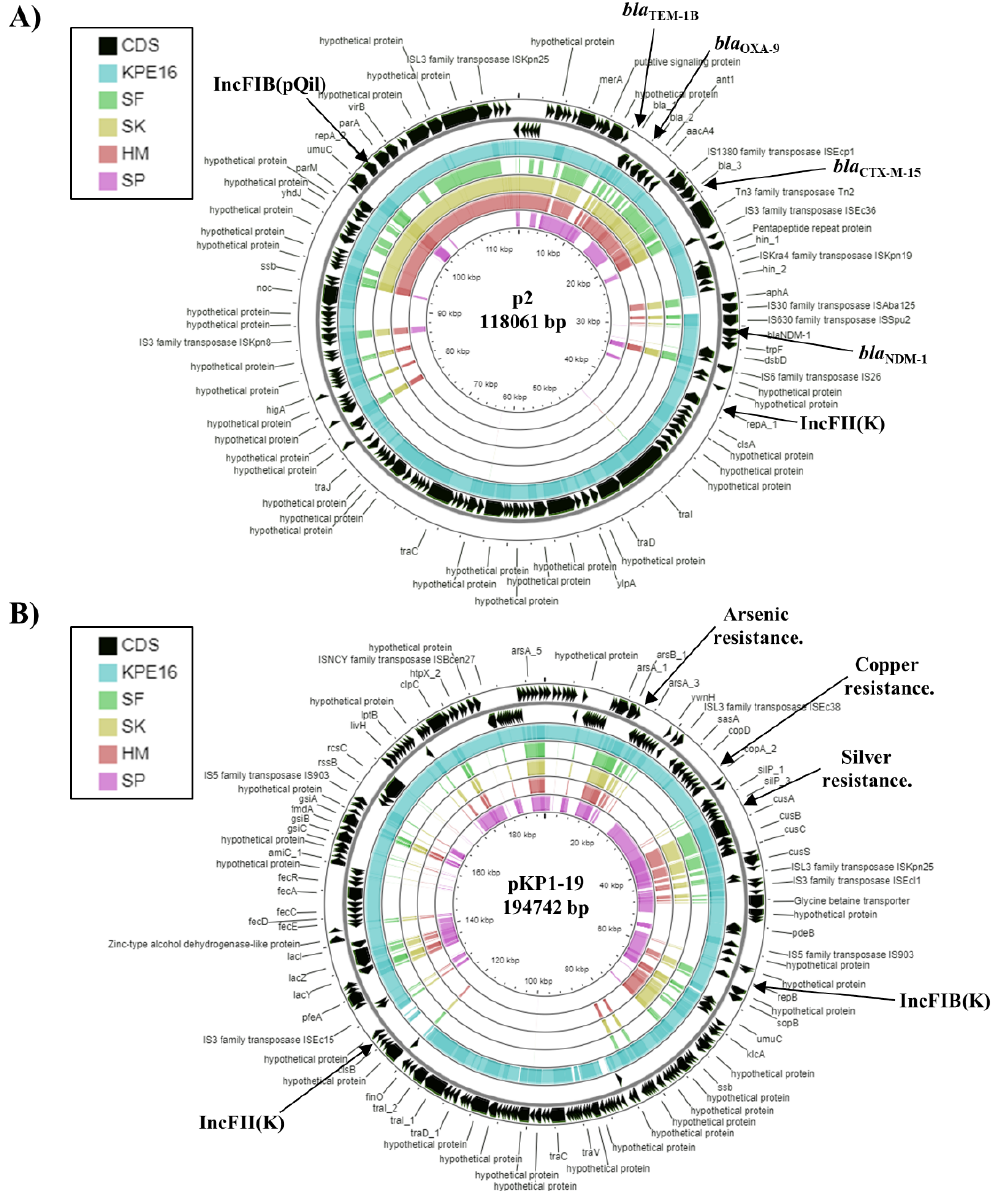
Figure 2. Analysis of plasmids carried by K. pneumoniae strain KPE16. The figure shows the comparison of the K. pneumoniae plasmids ( A ) p2 (CP009115.1) [14] and ( B ) pKP1–19 (CP012884.1) [44] with the genomes of K. pneumoniae strains KPE16, SF, SK, HM, and SP using GCview [32]. In both panels, the outer two rings display the genes (CDS) of each plasmid on both strands, with plasmid replicons and selected features labelled. The blue, green, gold, red, and pink shading illustrates the BLAST results when the genome sequences of KPE16, SF, SK, HM, and SP, respectively, are compared with each plasmid. Shaded regions indicate homology.